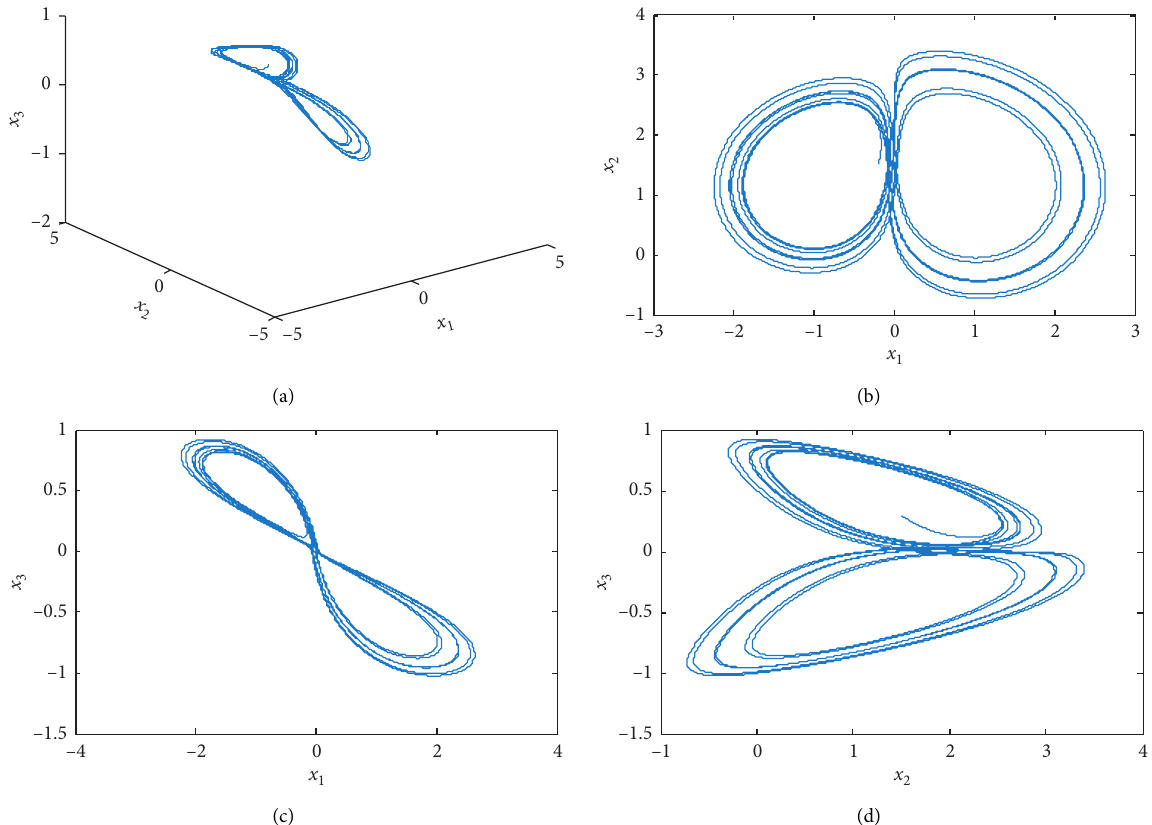
,x , x ) space; (b) projection in ( x 1 2 3